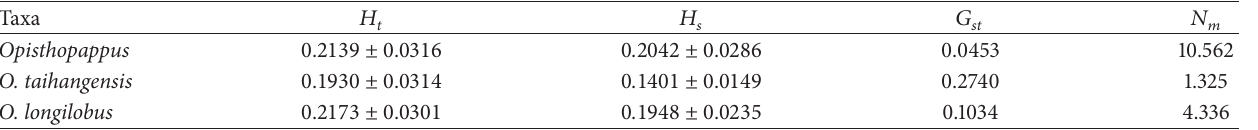
Table 2: Nei’s total genetic diversity index ( 𝐻 𝑡 ), genetic diversity index in populations ( 𝐻 𝑠 ), genetic differentiation coefficient ( 𝐺 𝑠𝑡 ), and gene flow ( 𝑁 𝑚 ) in Opisthopappus